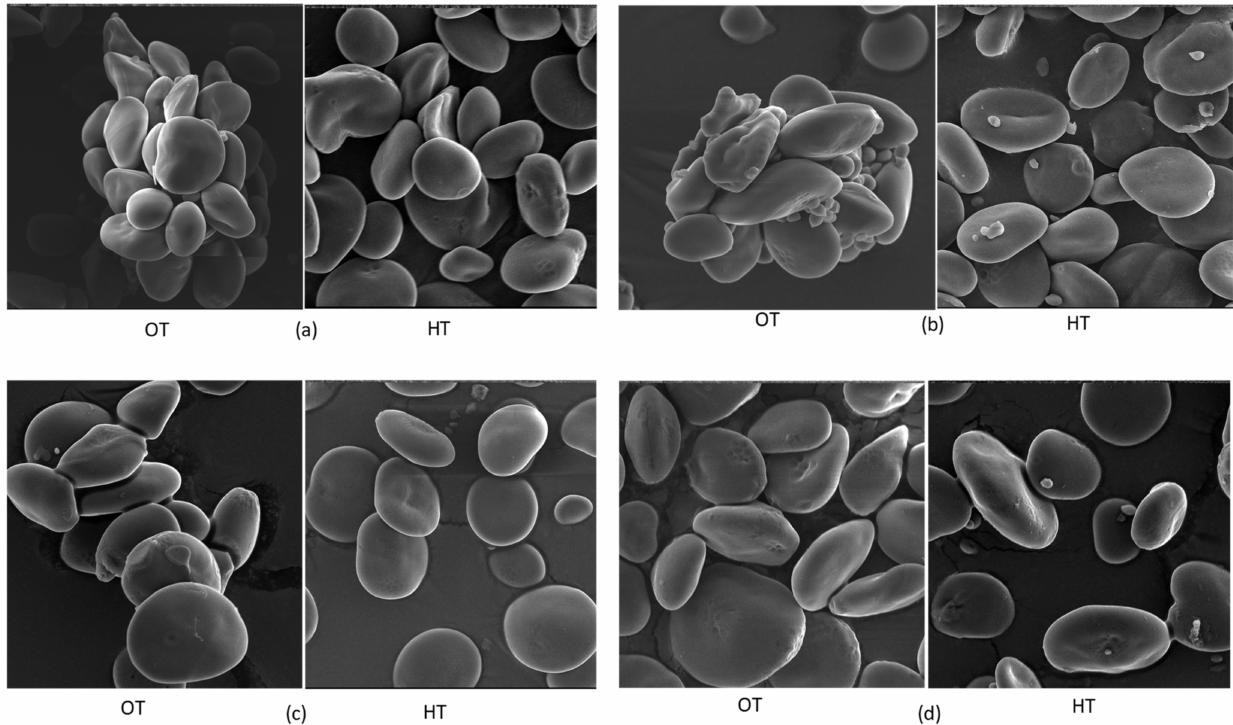
Figure 5. SEM (Scanning electron microscope) micrographs (randomly taken from both grain-filling and anthesis stage) showing the distribution of flag leaf starch in different wheat genotypes under different regimes of temperature. In general starch granules are intact at OT butdisperse at HT:( a ). Fakhr-e-Bhakar; ( b ). Raj-3765; ( c ). Jimai-22; ( d ).